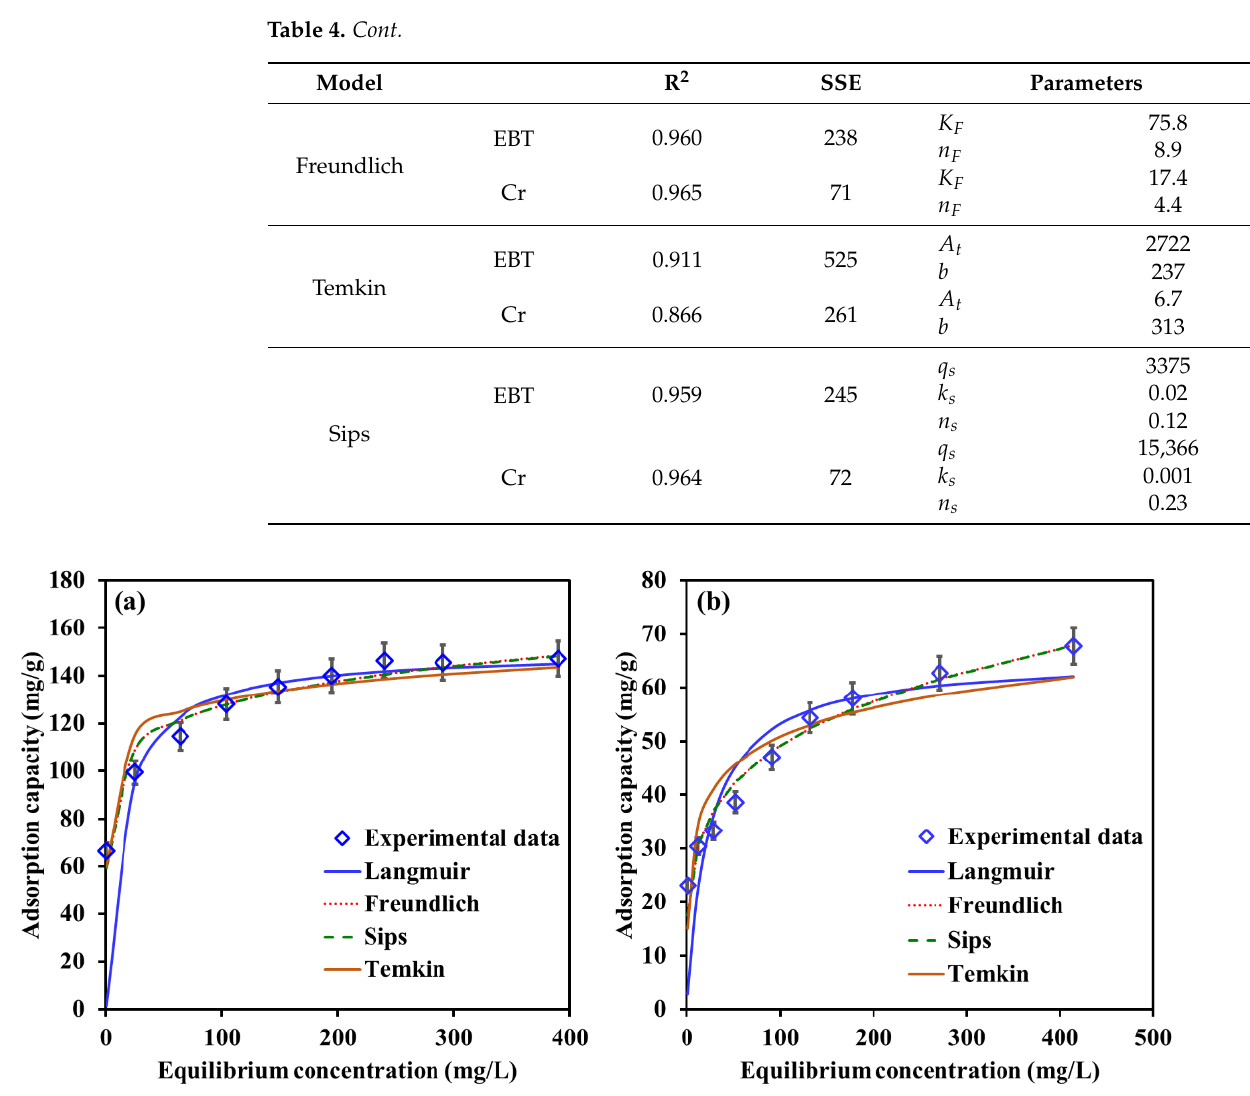
Figure 14. Best nonlinear fit of adsorption isotherms of ( a ) EBT and ( b ) Cr removal by Mg-Ca-Al-LDO composite. Temperature, 22 °C; contact time, 24 h; dosage, EBT 0.75 g/L, Cr 1.25 g/L; [pH] I , EBT 5.2, Cr 6. Table 4. Statistical parameters (R 2 and SSE) and isotherm parameters of the investigated isotherms on EBT and Cr removal by Mg-Ca-Al-LDO composite.